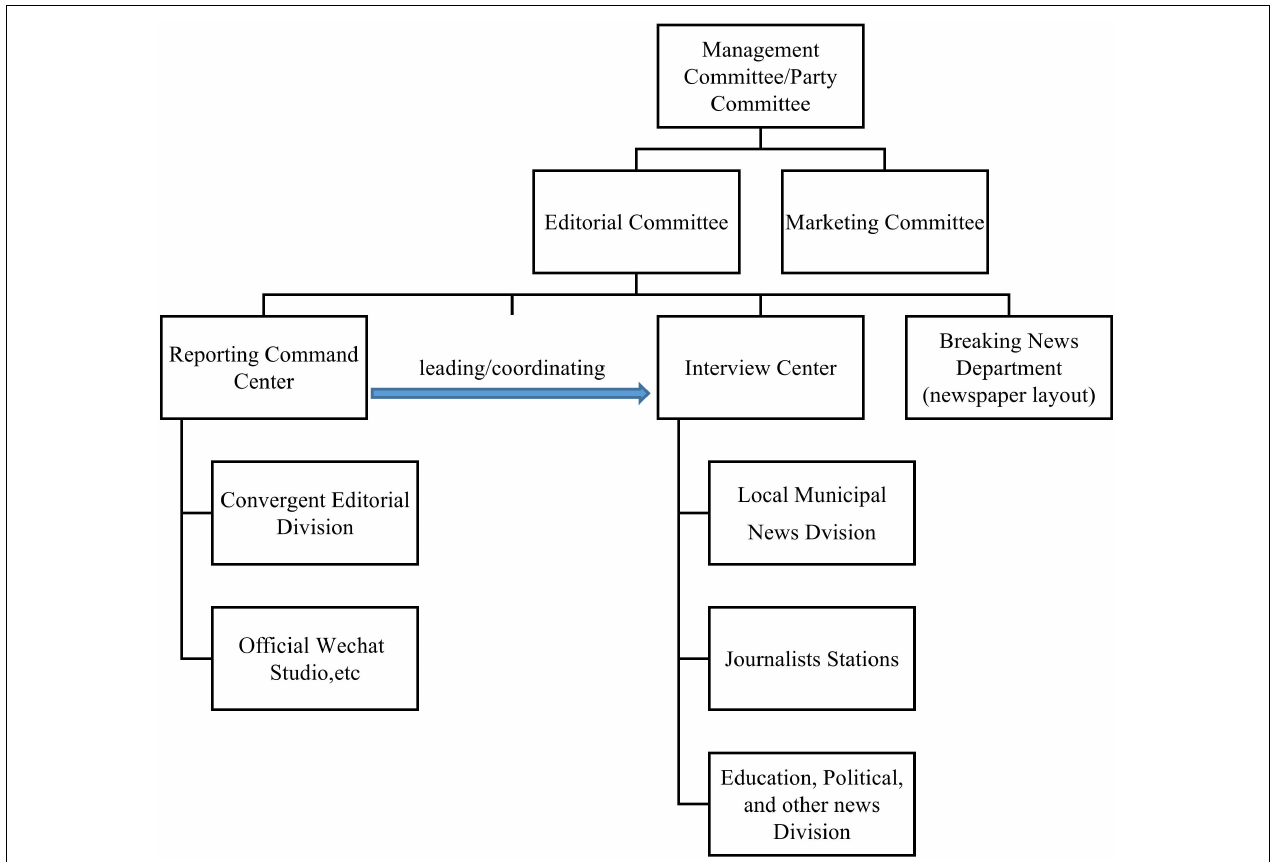
FIGURE 1 | The organizational structure of N in the exploration